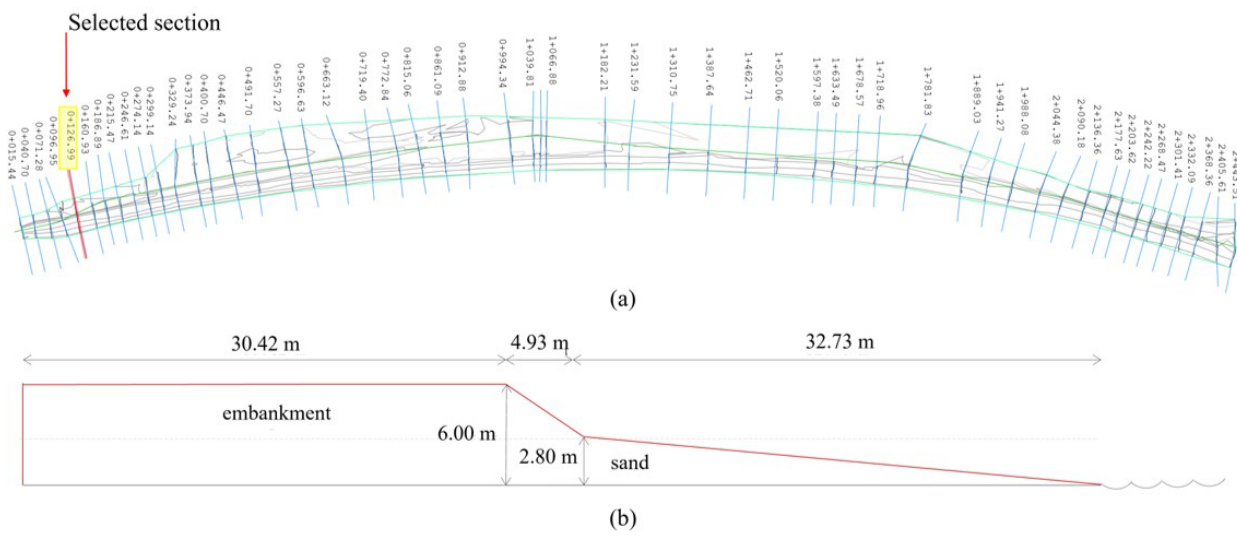
Figure 5. (a) Cross-sections taken along the road and (b) the cross-section used in the